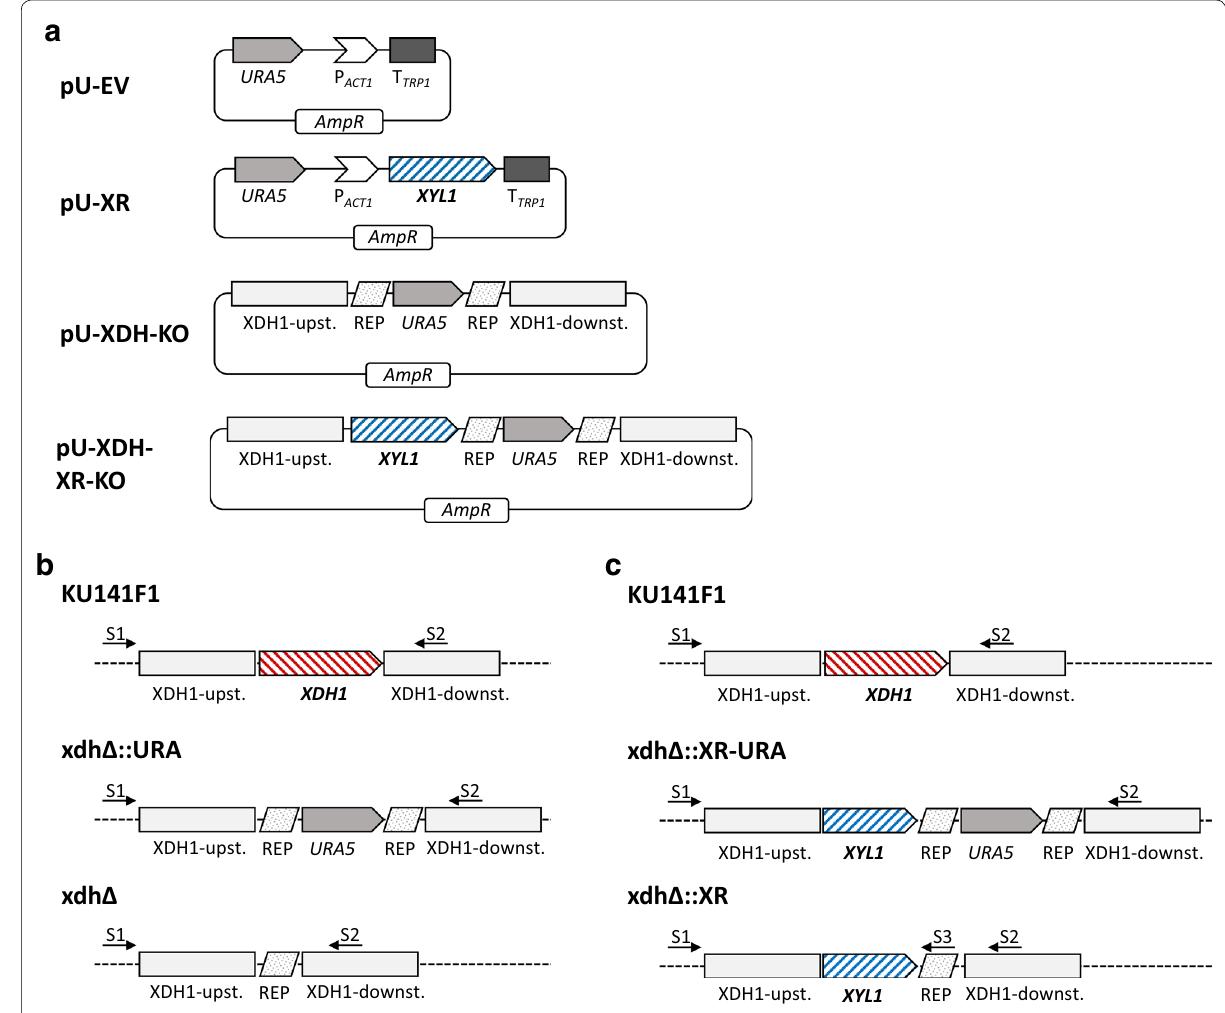
Fig. 2 Schematic representation of the plasmids used and generated in this study, and the resulting genetic modifications. a shows the vectors used in this study: pU-EV is the empty vector used as control, pU-XR is used for the overexpression of the xylose reductase gene XYL1 , pU-XDH-KO for the knockout of the xylitol dehydrogenase gene XDH1 , and pU-XDH-XR-KO for genomic replacement of XDH1 by XYL1 . b Deletion of XDH1 by homologous recombination of the selection cassette (xdh∆::URA) and after release of URA5 by Ura-Blaster (xdhΔ) in the parental strain M. guilliermondii KU141F1. c Replacement of XDH1 by XYL1 (xdh∆::XR-URA) and after release of URA5 by Ura-Blaster (xdh∆::XR) in the parental strain KU141F1; AmpR: Ampicillin resistance gene; URA5 : selection marker for uridine-prototrophy, P ACT1 : ACT1 promotor for constitutive expression of XYL1 , T TRP1 : Terminator of XYL1 expression; REP: repetitive sequences for the use of the Ura-Blaster system to release URA5 selection marker; XDH1-upstr.: genomic sequence 1000 bp upstream of XDH1 ; XDH1-downst.: genomic sequence 1000 bp downstream of XDH1; S1, S2 and S3 indicate sequencing primer binding